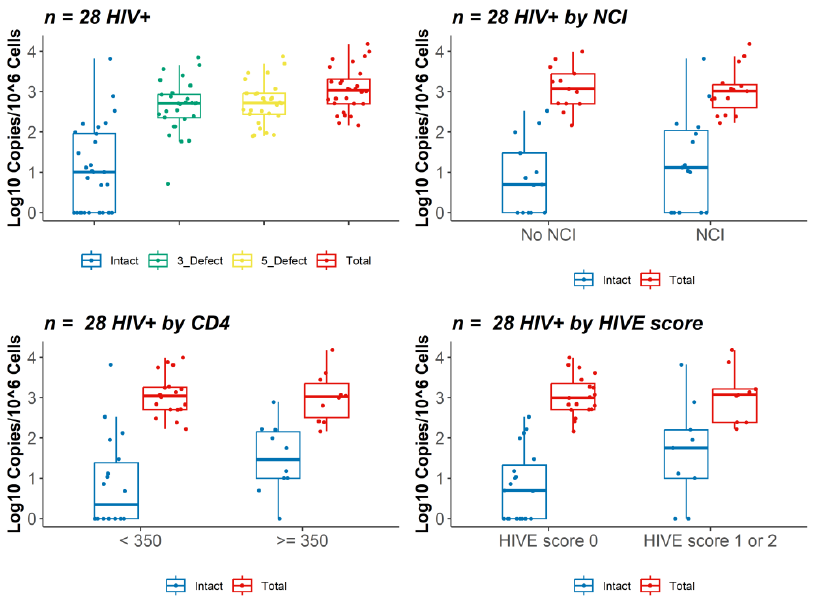
Figure 1. IPDA analysis of HIV proviruses in brain tissue from 28 HIV+ individuals on ART. Log10 copy number (standardized to 10 6 cells) of proviral genomes defined as intact (blue), 3′ defective (green), 5′ defective (yellow), or total (sum of intact, 3′ defective, and 5′ defective; red) was measured in autopsy brain tissue (frontal white matter) from HIV+ individuals on ART ( n = 28) (top left). Log10 copy number of intact and total proviruses in groups by neurocognitive impairment (NCI, n = 15) vs. no neurocognitive impairment (No NCI, n = 13), last CD4 count <350 ( n = 18) vs. last CD4 count ≥ 350 ( n = 10), or HIVE score 0 ( n = 19) vs. HIVE score 1 or 2 ( n = 9) (top right and bottom panels). Horizontal bars represent medians, boxes span the interquartile range (IQR), and whiskers extend to extreme data points within 1.5 times the IQR.